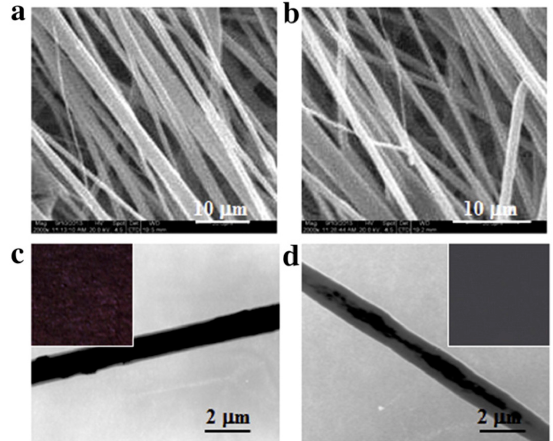
Figure 7. ( a , b ) Typical SEM and ( c , d ) TEM images of blend ( a , c ) and coaxially electrospun fibers ( b , d ) containing 5% CNTs. Insets in c and d show the physical appearance of fibrous mats obtained. Reprinted from [130] with permission from Elsevier.